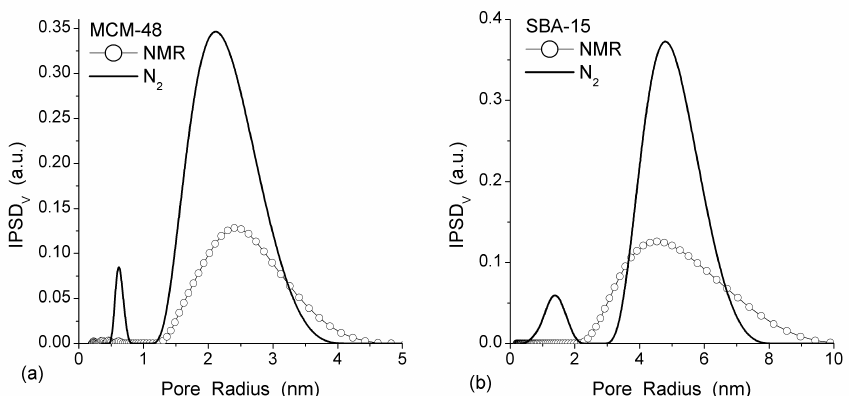
Fig. 8 IPSDs for (a) MCM-48 and (b) SBA-15 calculated on the basis of the nitro- gen adsorption isotherms and the ISDs based on the 1 H NMR spectra of water and water/benzene calculated using IGT (Eq. (5)) and MEM-0 with Eq. (9). Figs. 11c and 11d correspond to the sum C u = C uw + C ub for unfrozen water (subscript ‘uw’) and benzene (subscript ‘ub’). Fig. 11e shows only the C uw ( T ) graphs calculated by deconvolution of the 1 H NMR